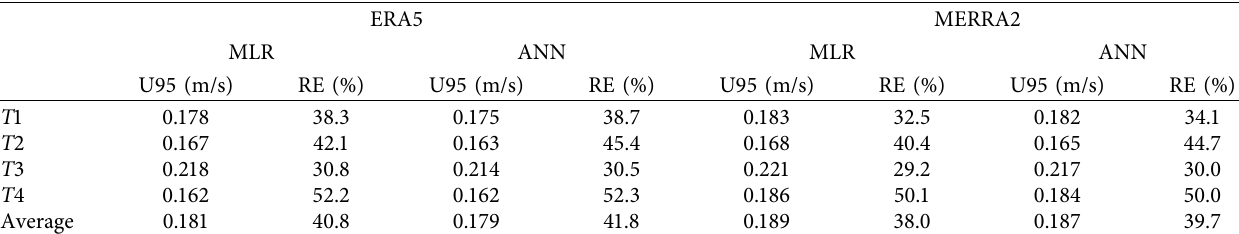
respectively) (Figure 8(a)). Similarly, for the V wind, the average RMSE predicted by the ANN method was 2.68 m/s and 2.78 m/s for ERA5 and MERRA2, respectively; the RMSE values were higher for the MLR method (the cor- responding RMSE was 2.80 m/s and 2.98 m/s, respectively).